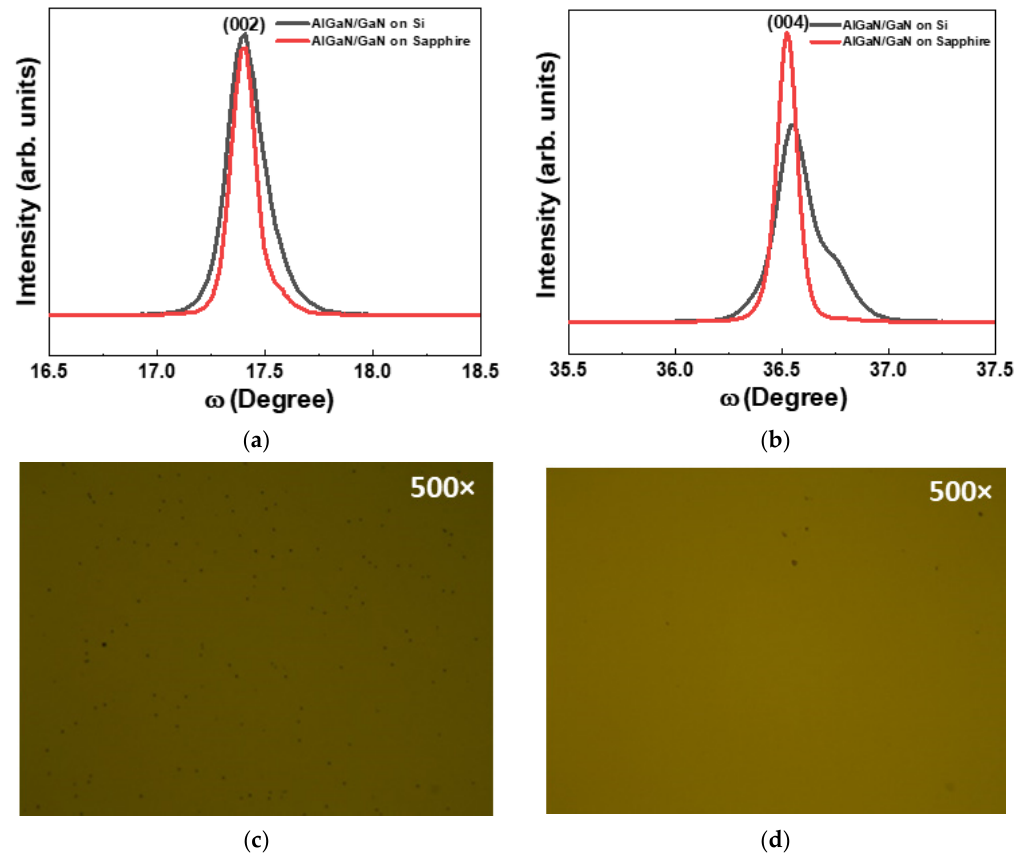
Figure 6. ω‐ scan rocking curves of ( a ) (002) and ( b ) (004) planes, optical microscope images of Al ‐ GaN/GaN surface grown on ( c ) Si and ( d ) sapphire. AlGaN/GaN surface grown on ( c ) Si and ( d ) sapphire. Table 1. Parameters of the AlGaN/GaN grown on different